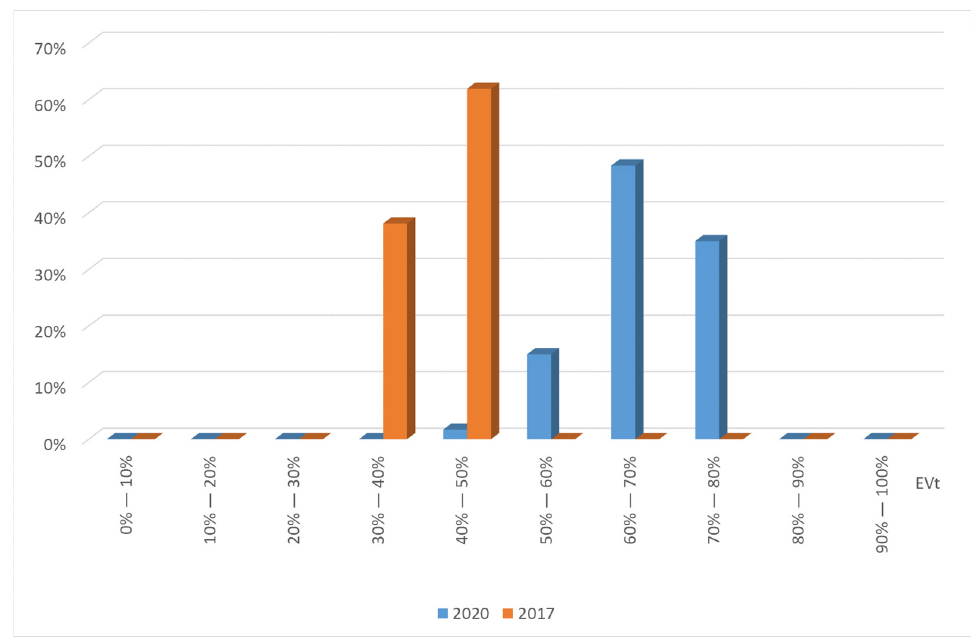
Figure 10. Frequency distribution of the EVt values.